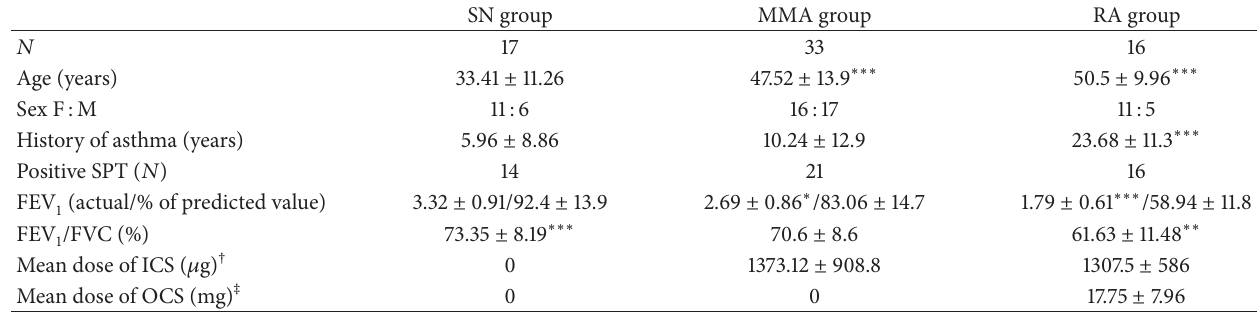
Table 1: Characteristic of study participants: steroid-na¨ıve asthma (SN), mild to moderate asthma (MMA), and refractory asthma (RA) cohorts. Values are presented as mean ± SD.